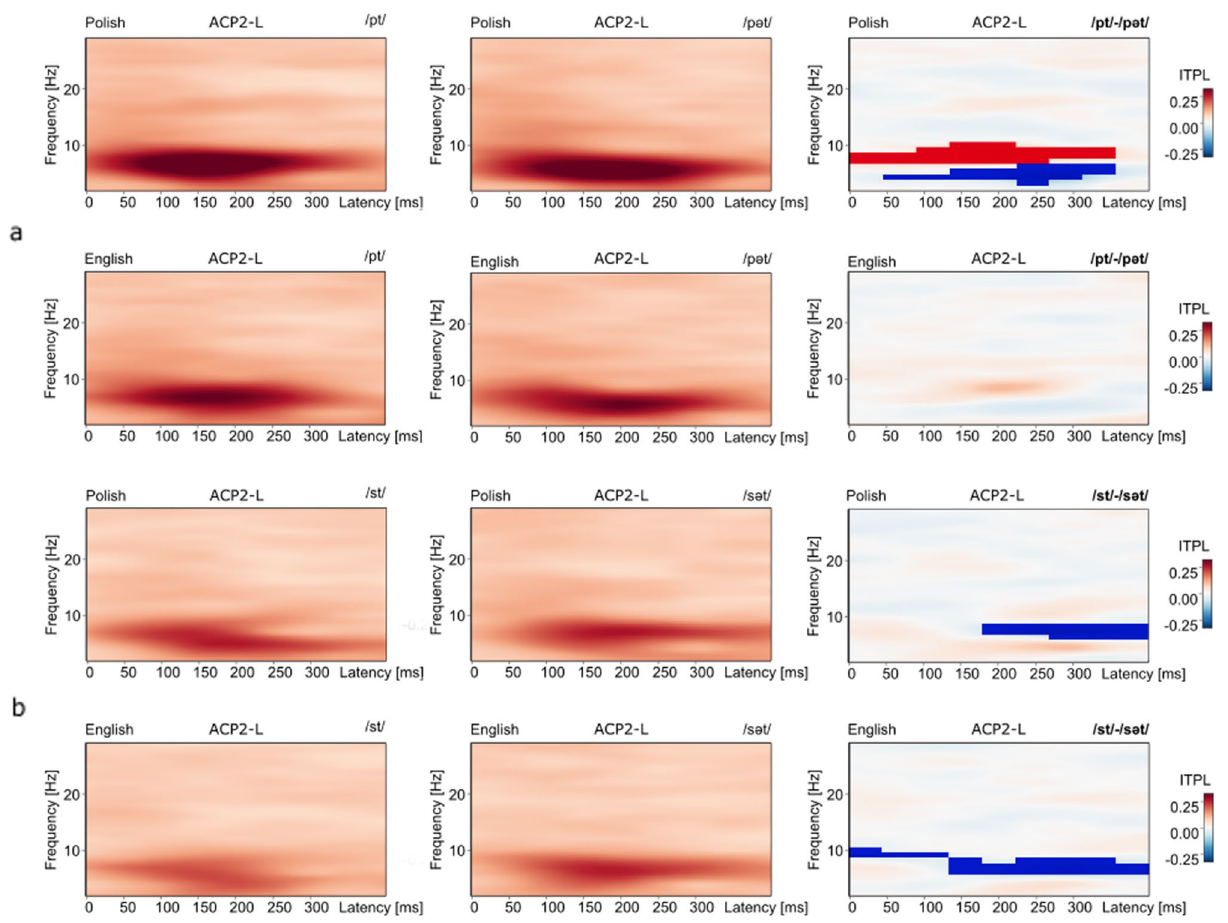
Figure 5. ITPL effects to the /pt-p ə t/ and /st-s ə t/ contrasts, passive condition. ( a ) The top row depicts, for the Polish group in the passive condition, significantly different ITPL values to the /pt-p ə t/ comparison in the high- theta band (max 8 Hz, 0–350 ms, p = 0.004) and the low-theta band (3–6 Hz, max 4 Hz, 50–350 ms, p = 0.028), from the same ACP2-L source. On the far right (top row), red masking depicts larger ITPL values in response to /pt/ in high-theta and blue masking depicts larger ITPL in response to /p ə t/ in low-theta, reflecting phase locking in select time–frequency bands for different phonological sequences. The bottom row in ( a ) shows a similar ITPL pattern for the English group to each onset sequence, however, differences were not significant. ( b ) Images show the ITPL values to the /st-s ə t/ comparison from the ACP2-L source, for the Polish (top) and the English (bottom) groups, also for the passive condition. For each group, ITPL values differed, significantly, only in high-theta (Polish: max 8 Hz, 200–400 ms, p = 0.042; English: max 6, 6–10 Hz, 0–400 ms, p = 0.014). Notice in the difference images on the far right, that for both language groups, larger ITPL values in high-theta are in response to the /s ə t/ onset syllable (blue masking). This is a different pattern than for the /pt-p ə t/ contrast, which found larger ITPL values in high-theta to the consonant cluster /pt/. See